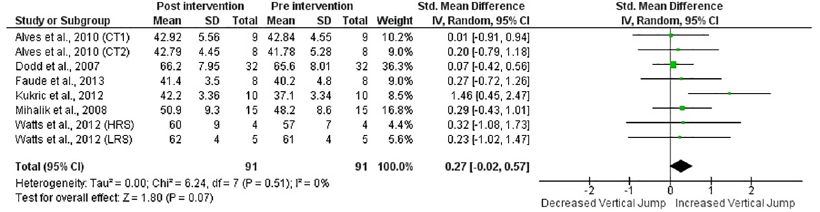
Fig 3. Standardized mean difference (SMD) between post and pre-intervention VJ height in CT-trained subjects. Squares representthe SMD a for each trial. Diamonds represent the pooledSMD across trials.